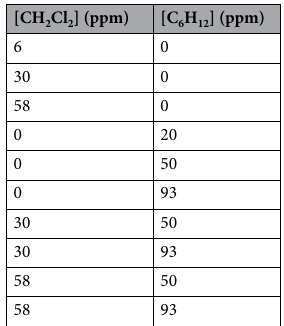
Table 1. Concentration of CH 2 Cl 2 and C 6 H 12 and their mixtures analyzed in the experiment.